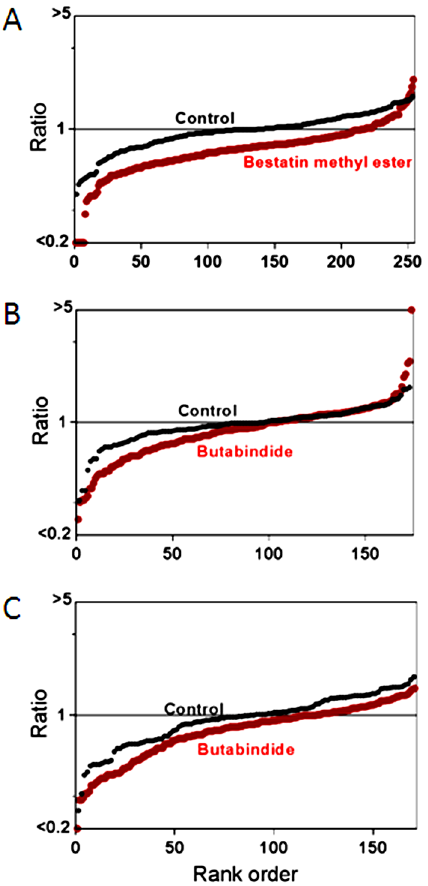
Figure 9. Summary plots of the peptidome of HEK293T cells in response to aminopeptidase inhibitors. Panels A–C represent data from experiments on HEK293T cells treated with (A) 100 m M bestatin methyl ester for 75 min; (B) 100 m M butabindide for 35 min; (C) 100 m M butabindide for 75 min. Specifications and criteria for the summary plots are described in Figure 3 legend.